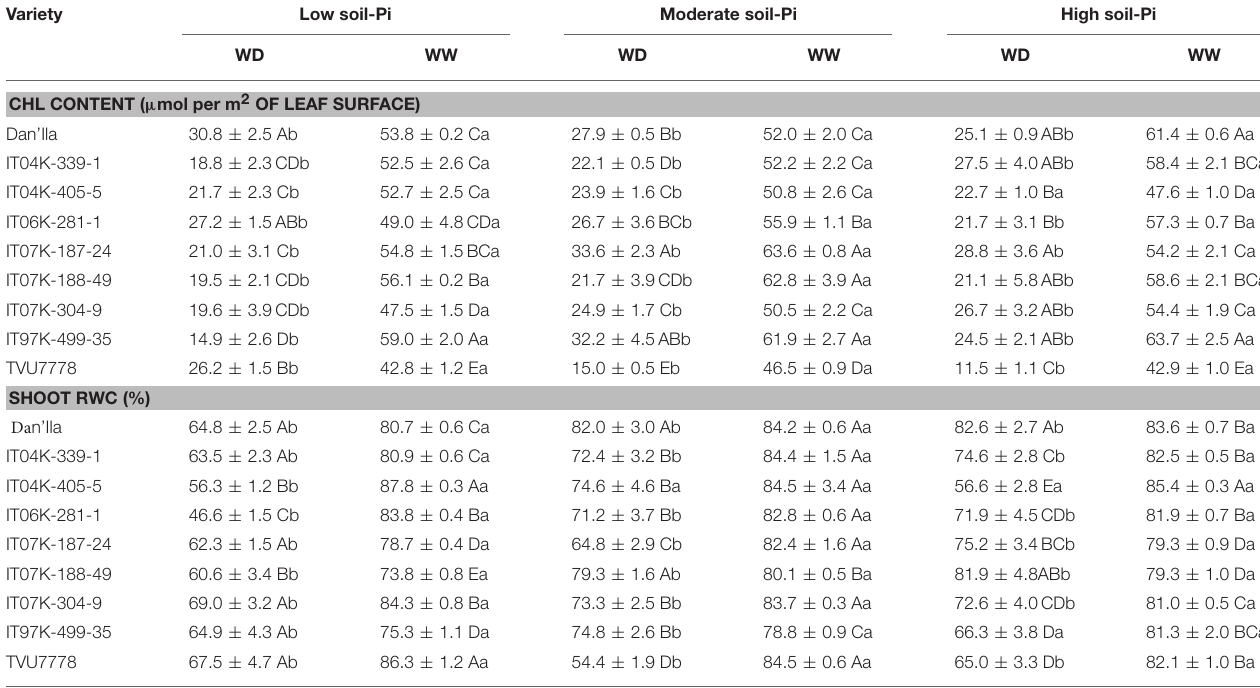
TABLE 2 | Chlorophyll (Chl) content and shoot relative water content (RWC) of cowpea varieties under different available soil-phosphate (Pi) levels (low available soil-Pi, moderate available soil-Pi, and high available soil-Pi) and soil water conditions (WW, well-watered; WD, water deficit). Variety Low soil-Pi Moderate